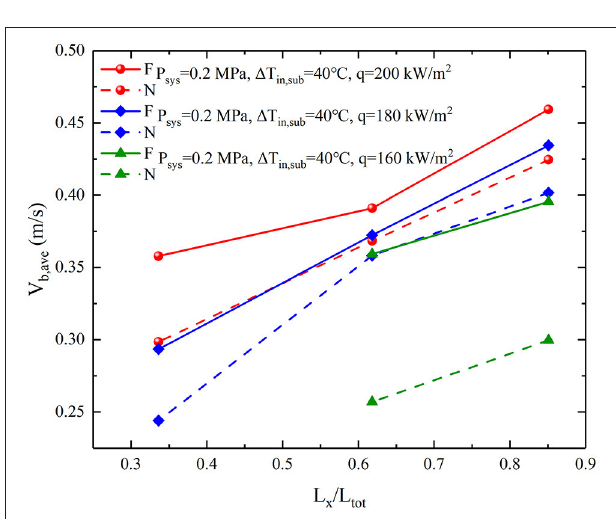
FIGURE 13 | The comparison between natural circulation and forced circulation of bubble velocity.